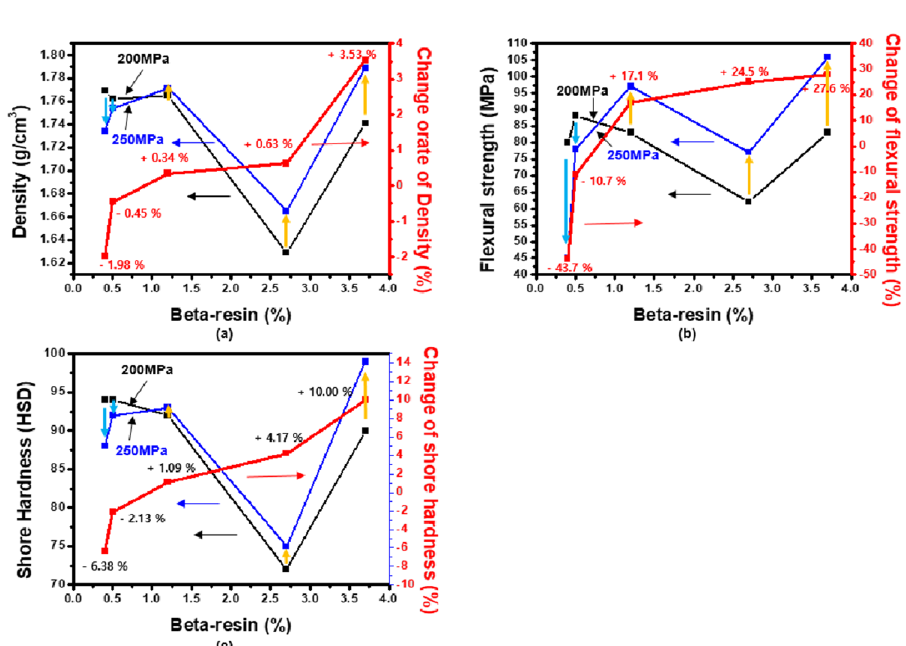
Figure 8. Changes in ( a ) density, ( b ) flexural strength, and ( c ) shore hardness of high-density carbon blocks after carbonization due to β-resin